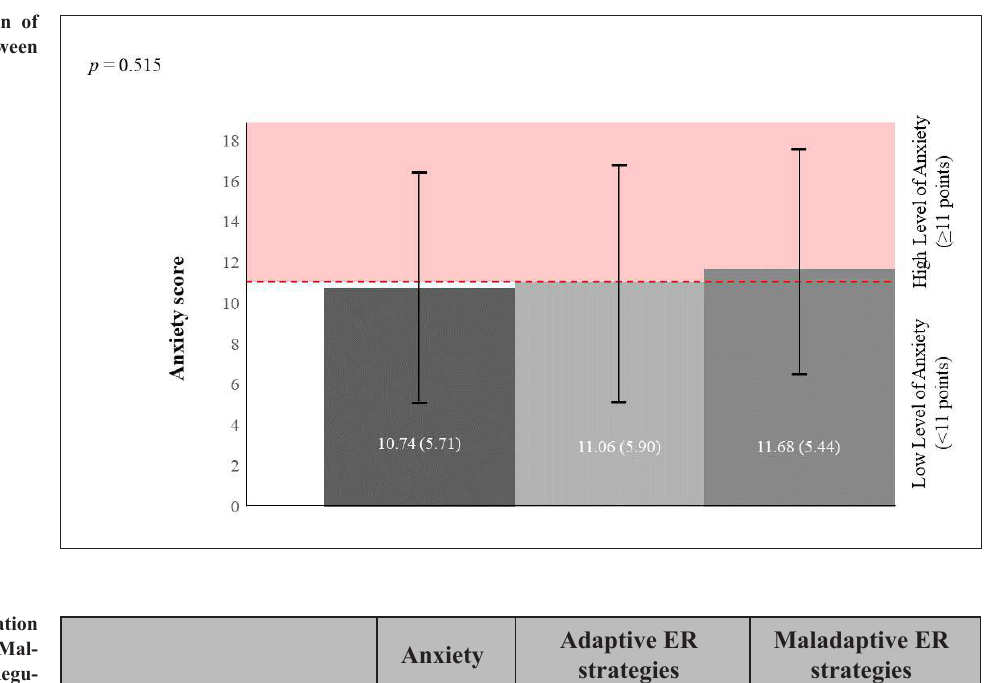
Figure 10. Correlation Between Adaptive, Mal- adaptive Emotion Regu-